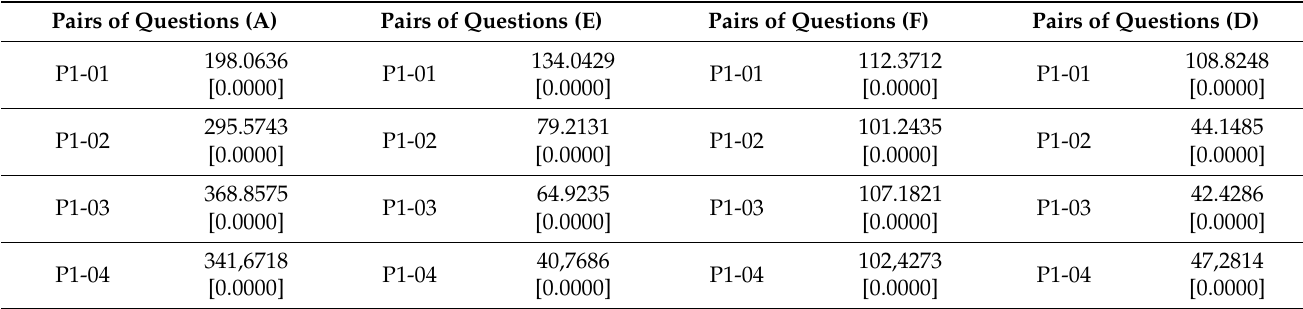
Table 2. Value of the χ 2